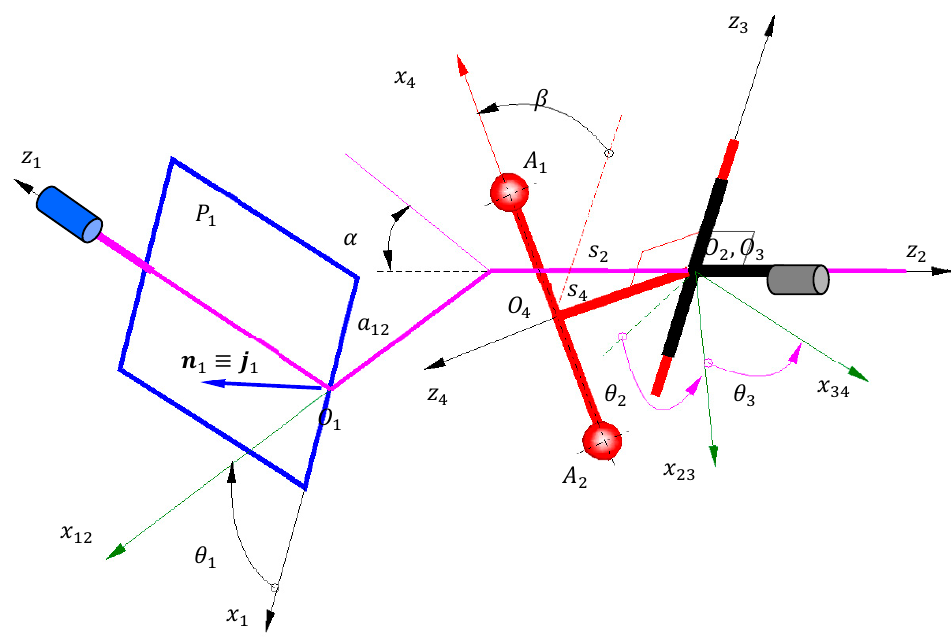
Figure 13. Coordinate systems and the constructive and positional parameters of the mechanism. The homogeneous operators correspond to roto-translation with respect to axis z and axis x , respectively. The relation of coordinate transformation from the system 4 to